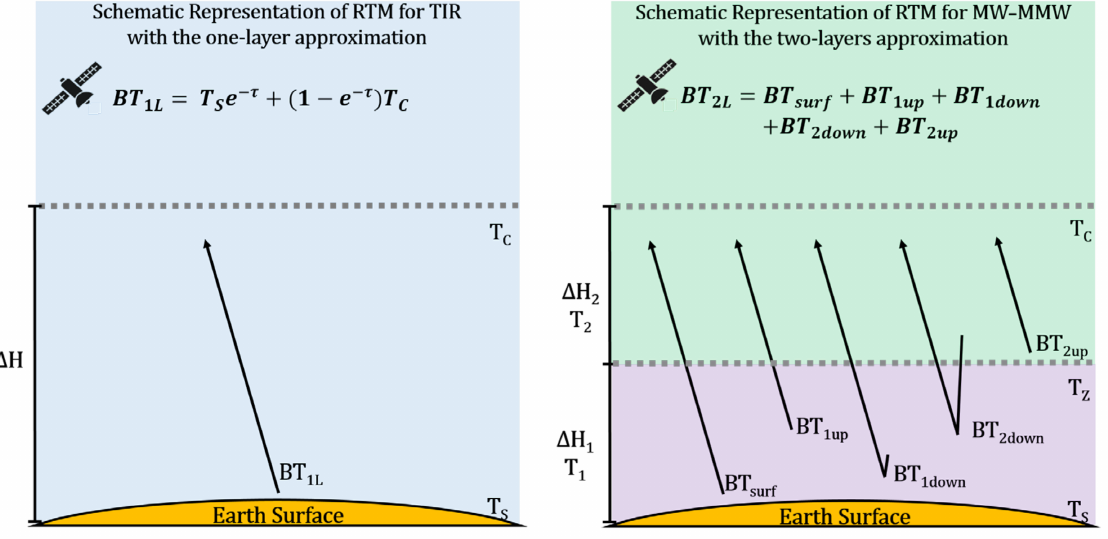
Figure 2. Schematic representation of the radiative transfer model. The left panel shows the one-layer approximation for the TIR observations. The right panel shows the two-layer approximation for the MW-MMW observations. The two dashed grey lines at the top of the two images represent the top of the cloud, whereas the middle grey line (only present on the right panel ) represents the end of the first